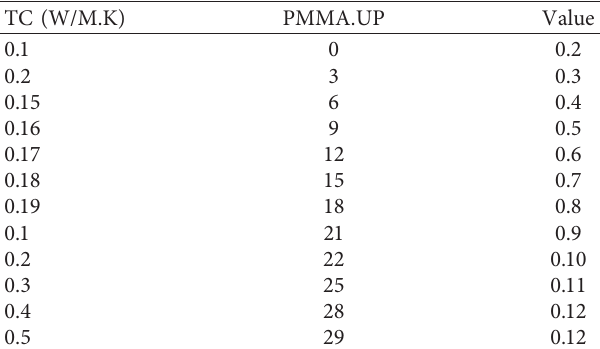
Table 2: Substantial